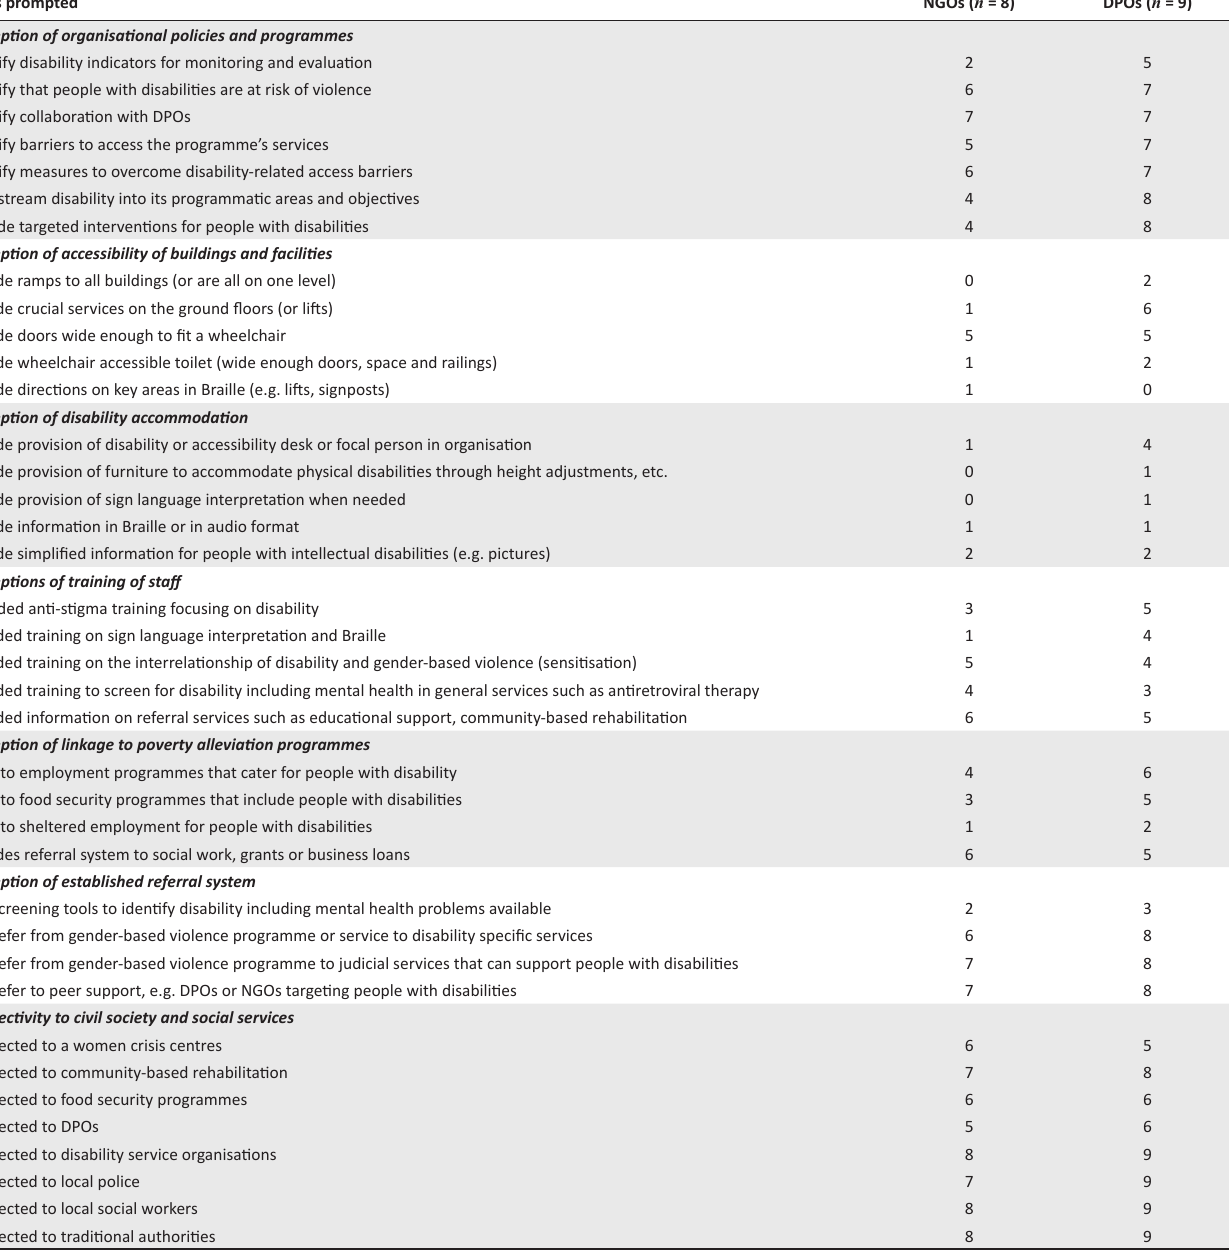
TABLE 2: Self-reported assessment using disability inclusion